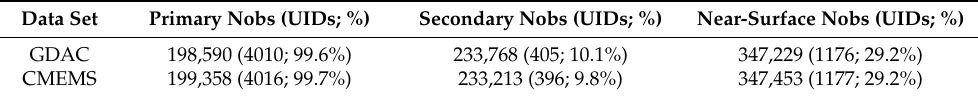
Table 6. The Nobs obtained with different VSSs. The first value in the parentheses is the number of UIDs that return the measurements. The percent value shows the fraction of UIDs to the total UIDs in the corresponding data set. Data Set